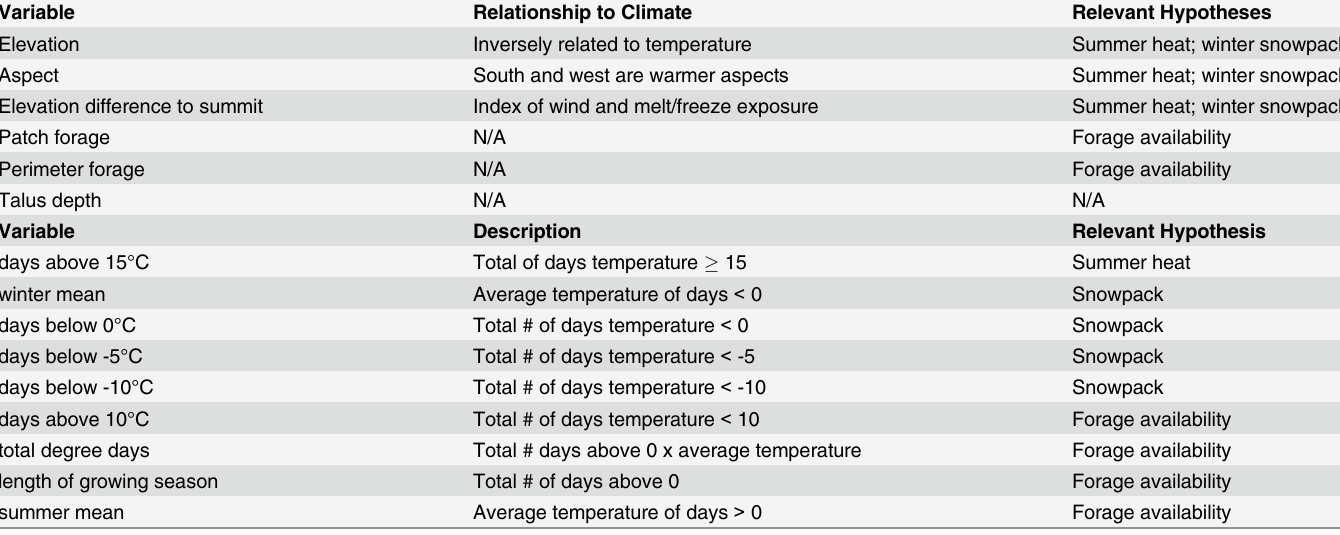
Table 1. Habitat variables (top) and derived climate variables (bottom) used in general linear models and model selection analyses of relative pika ( Ochotona princeps ) scat density in the Wind River (2010) and Bighorn (2011) mountain ranges, Wyoming,